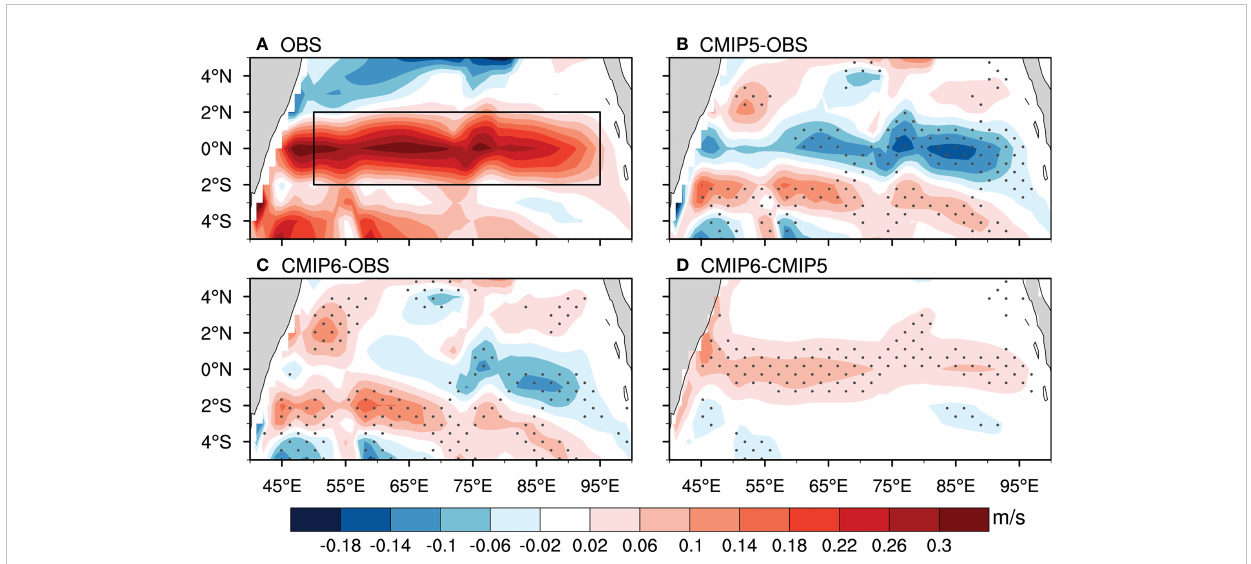
FIGURE 2 (A) FMA mean observed subsurface (averaged from 60 to 150 m) zonal current (units: m/s) over the EIO from the SODA 3.4.2 dataset. The black box denotes the domain of the Indian Ocean EUC (2° S – 2° N, 50 – 95° E). The MME biases of the EIO subsurface zonal currents in the (B) CMIP5 and (C) CMIP6 models, the gray dots denote locations over which >70% of models agree on the same sign of subsurface zonal current bias. (D) Difference in the EIO subsurface zonal current between the CMIP6 and CMIP5 models; the gray dots indicate signals that are statistically signi fi cant at the 90% con fi dence